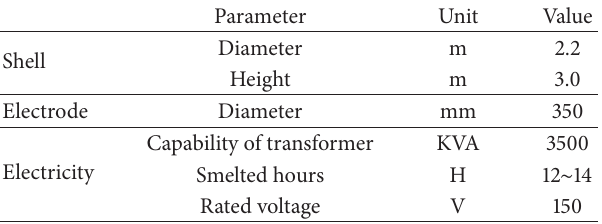
Table 3: Parameters of arm-type electro-fused magnesia